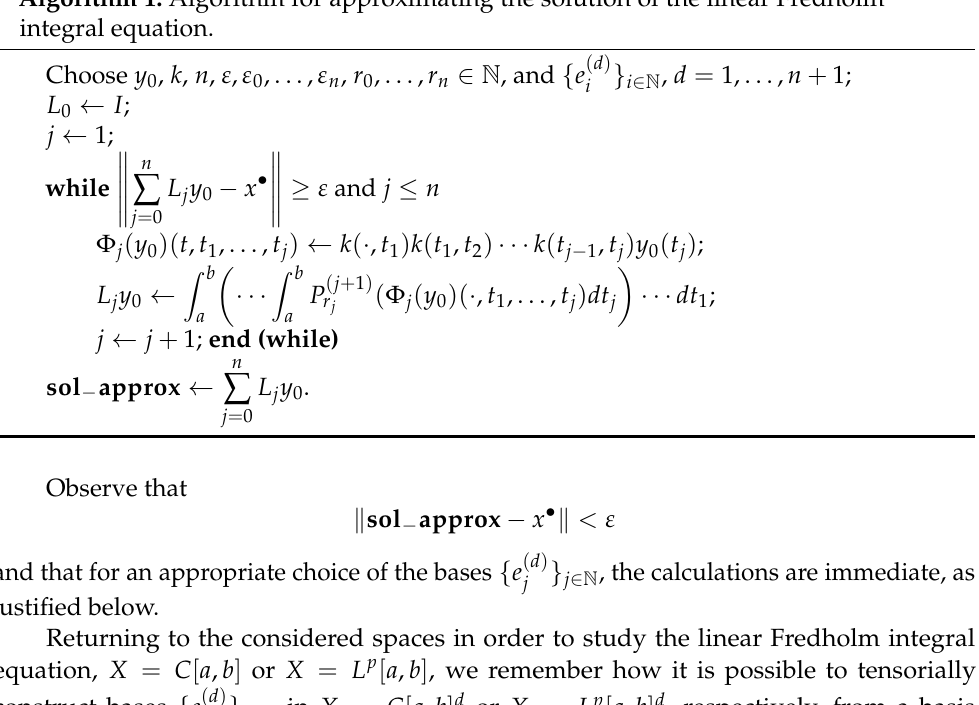
Algorithm 1: Algorithm for approximating the solution of the linear Fredholm integral